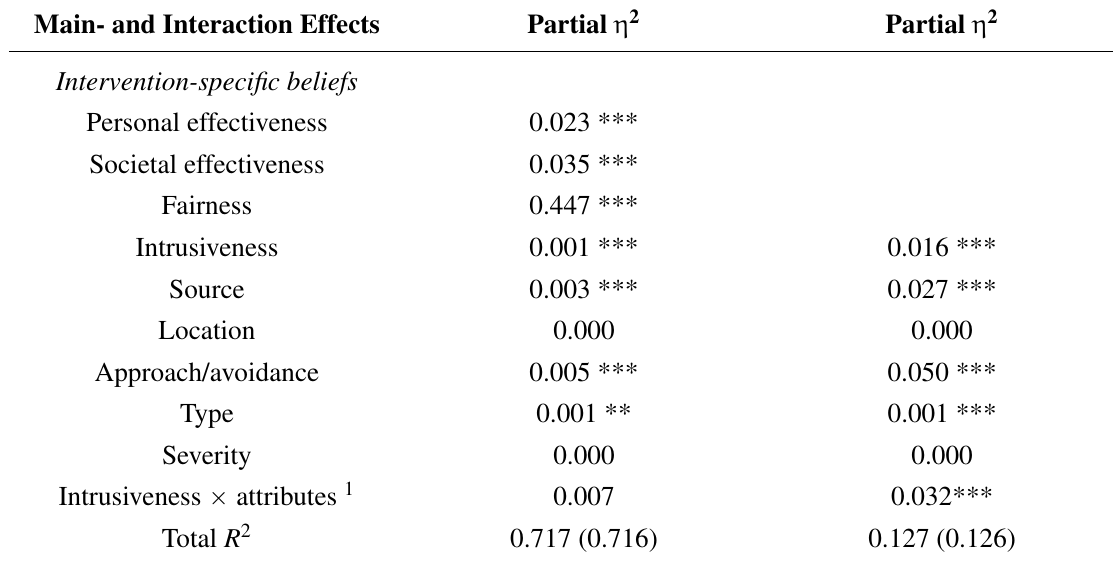
Table 7. Effect sizes (partial η 2 ) of intrusiveness and intervention attributes on acceptance of interventions, with (left column) and without (right column) adding intervention-specific beliefs to the model (snack foods and beverages